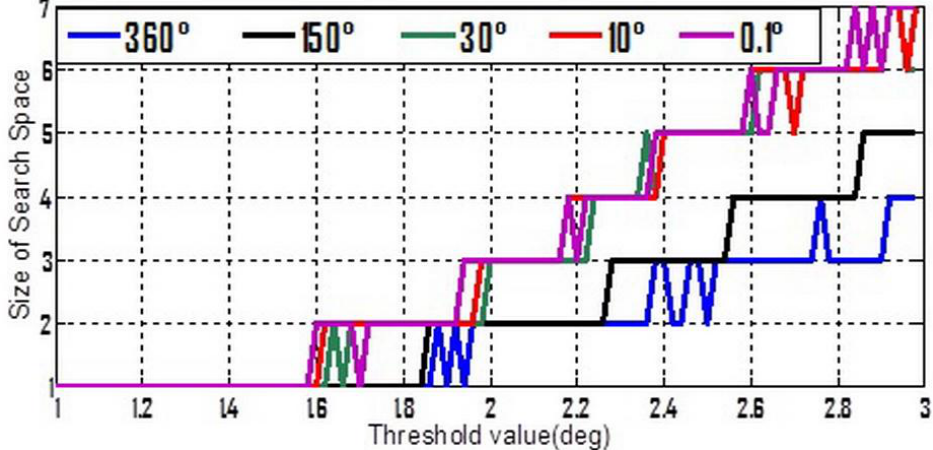
Figure 4. Shrinking efficiency varies with threshold at different accuracy of